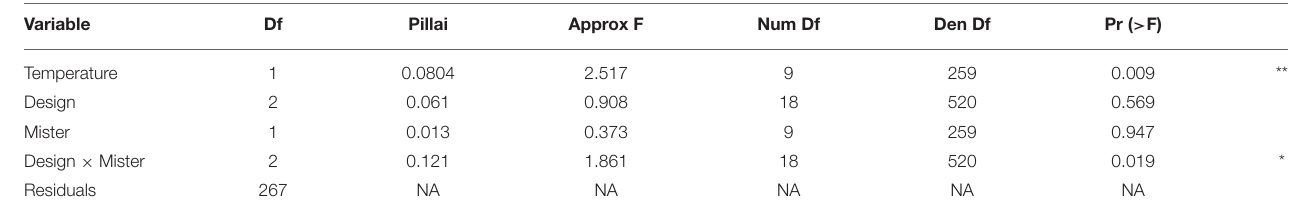
TABLE 5 | Results of the MANCOVA test including the status of the water